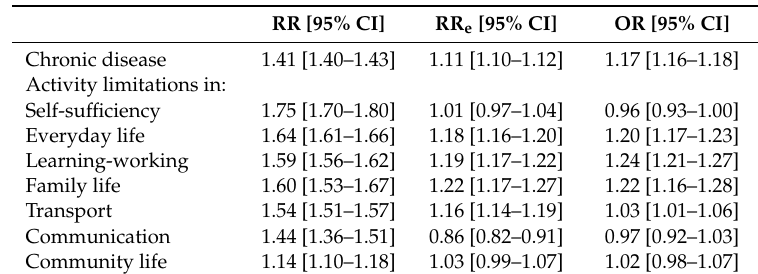
Table 3. Roma ethnicity’s association with the occurrence of having at least one chronic disease and activity limitations among those with chronic disease, according to age- and sex-standardized risk ratios (RR); age-, sex-, and education-standardized risk ratios (RR e ); and multivariate logistic regression analyses